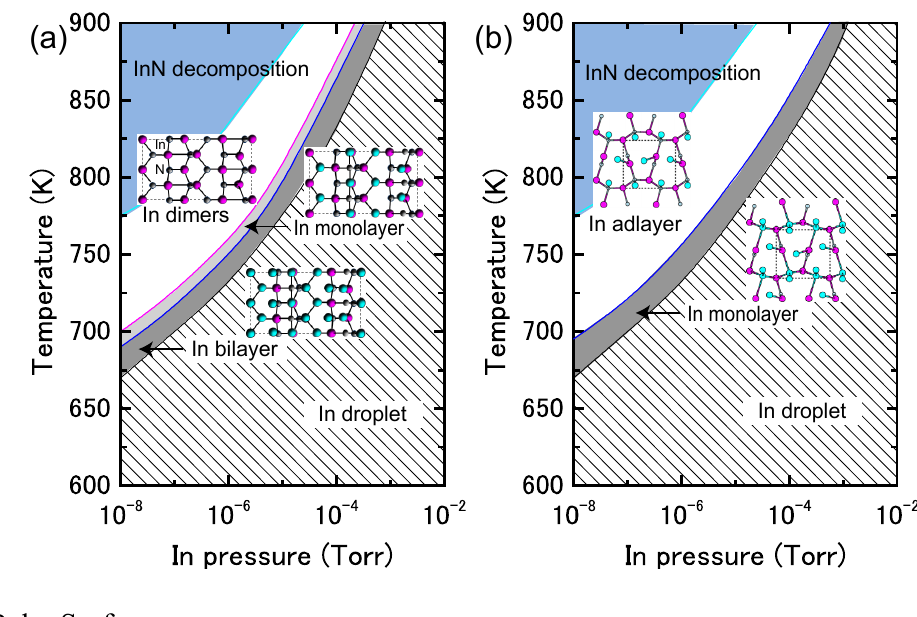
Figure 22. Calculated phase diagrams for nonpolar InN surfaces with ( a ) (11 _ ( b ) (112 2) orientations as a function of temperature and In BEP. The stable reconstructions on these surfaces are also schematically